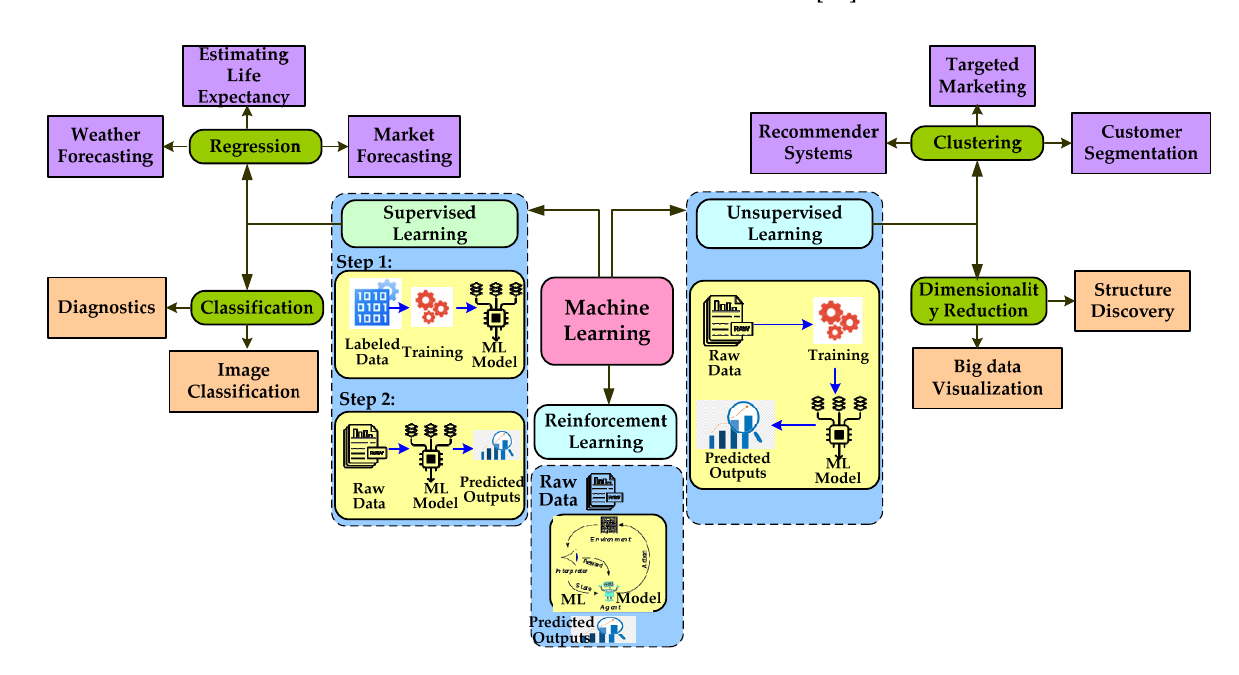
Figure 6. Categories of machine learning algorithm.